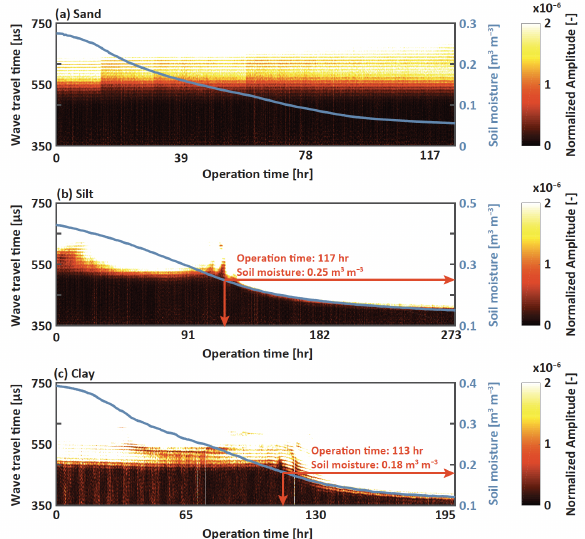
Figure 6. Stacked waveform images from ( a ) sand, ( b ) silt, and ( c ) clay. The bright colors in ( a – c ) represent normalized amplitudes. The x-axis represents the experimental operation time and left and right y-axes represent TOF and soil moisture,